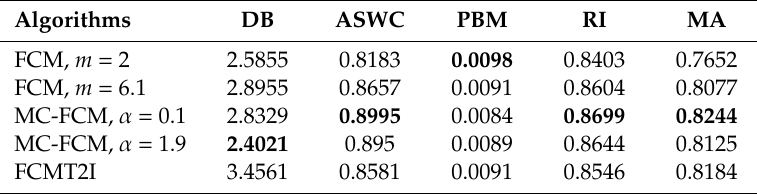
Table 2. Experimental results with the ECOLI dataset, 336 samples, 8 clusters, m L = 5.5, m U = 6.5.